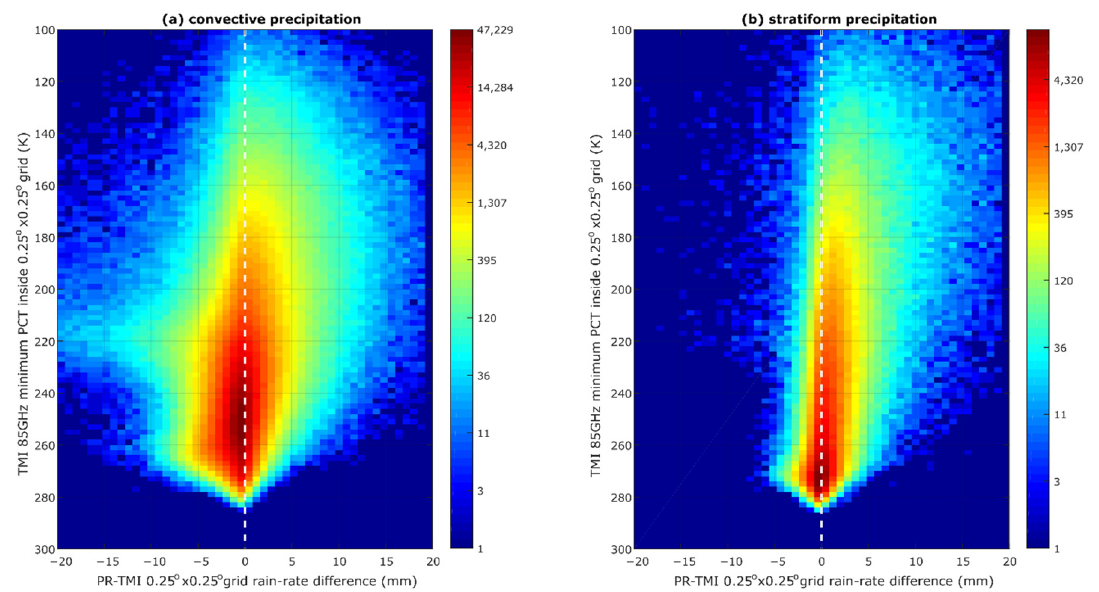
Figure 5. Joint frequency histogram of the gridded rain-rate estimation difference between PR and TMI regarding the minimum TMI 85 GHz PCT value at the same grids for ( a ) convective precipitation and ( b ) stratiform precipitation. (Source: data processing).